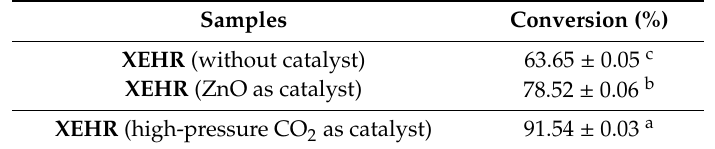
Table 1. Esterification conversion values under di ff erent catalytic conditions. Reaction conditions: (1) no catalyst, (2) the traditional ZnO catalyst (0.8%), (3) high-pressure CO 2 as the catalyst (4 MPa). Common reaction conditions: temperature = 250 ◦ C, time = 4 h, molar ratio of hydrogenated rosin to xylitol =